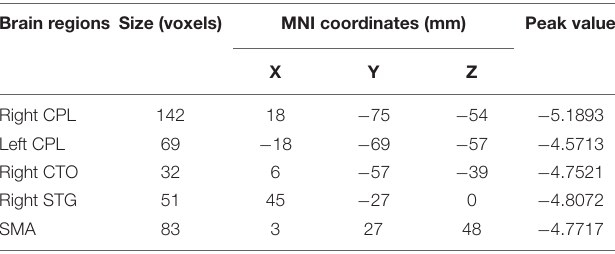
( Figure 4B ), and there is a negative association between age, UPDRS scores, and the concordance values in STG ( r = = − 0.278, − 0.304; P = =0.036, 0.021) ( Figures 4C–E